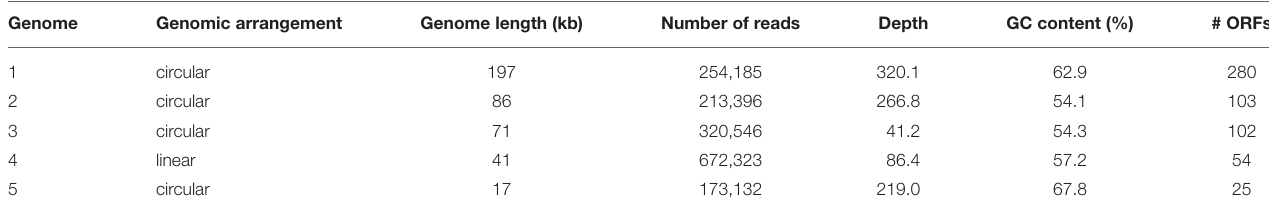
TABLE 2 | Genomic characteristics of the five putative complete viral genomes retrieved from the viral metagenome of the bacteriophage population in the Methylomirabilis bioreactor enrichment culture.